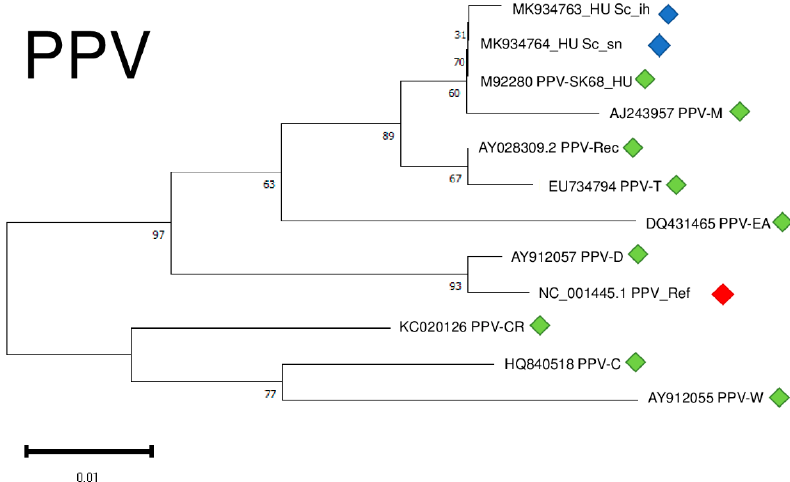
Figure 10. Evolutionary analysis of 427 bp, partial CP coding regions of different PPV isolates by Maximum Likelihood method. The evolutionary history was inferred by using the Maximum Likelihood method and Tamura-Nei model. The tree with the highest log likelihood ( − 921.09) is shown. The percentage of trees in which the associated taxa clustered together is shown below the branches. Initial tree(s) for the heuristic search were obtained automatically by applying Neighbour-Join and BioNJ algorithms to a matrix of pairwise distances estimated using the Tamura-Nei model, and then selecting the topology with superior log likelihood value after 1000 Bootstraps. Alignment of the sequences was done using MUSCLE. Evolutionary analyses were conducted in MEGA11. Red box is the reference genome, green boxes indicate PPV strains from the NCBI GenBank, while blue boxes indicate PPV isolates from the Hungarian isolator houses.